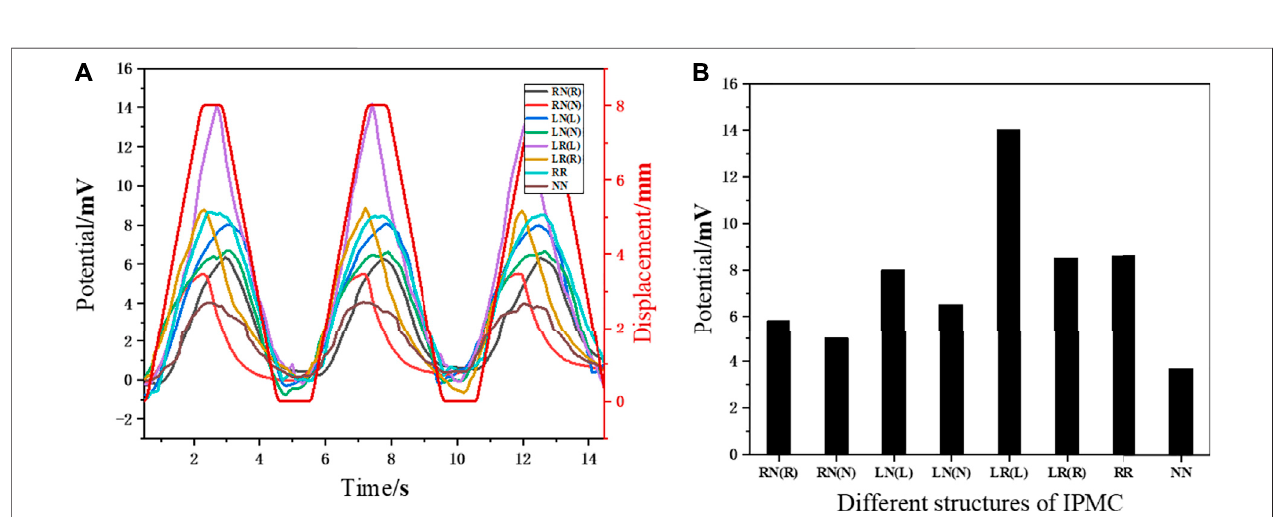
FIGURE 5 | Voltage generated by the fi ve IPMC samples. (A) The instantaneous real-time response of IPMC samples with the comparison of the displacement stimuli. (B) The diagram of the generated peak voltage value.